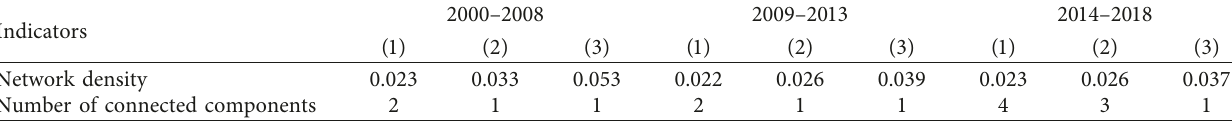
Table 4: The change of network density and number of connected